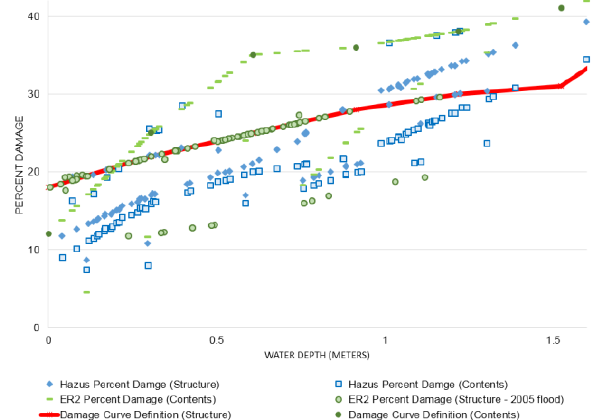
Figure 8. Percent Damage based on water level and depth damage curve, one-story single family residence with no basement